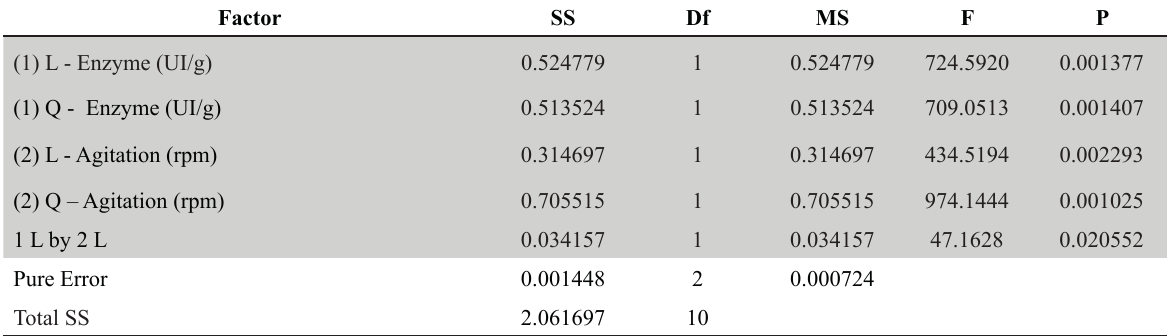
Enzymatic hydrolysis optimization - ANOVA statistics data of independent variables and their interactions; dependent variable (RC concentration